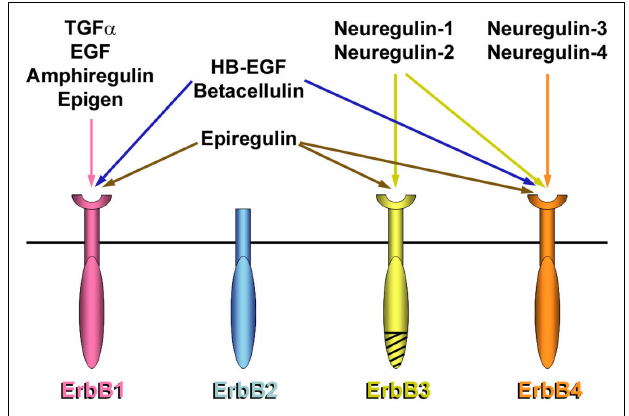
FIGURE 2 |The erbB family of receptors and their ligands. ErbB1 (or EGFR, epidermal growth factor receptor) and erbB4 are fully functional receptors that possess an extracellular ligand-binding domain and a cytoplasmic protein tyrosine kinase domain and can function as homo- or heterodimers. In contrast, erbB2 (or neu), which lacks a ligand-binding domain, and erbB3, which is defective in its intrinsic tyrosine kinase activity (dashed lines), must heterodimerize with another member of the erbB family for signal transduction.The different EGF-like growth factors exhibit different binding specificities for the erbB receptors.WhileTGF α , EGF, amphiregulin, epigen, neuregulin-3, and neuregulin-4 are specific for a single member of the receptor family, the five other EGF-like ligands can bind two or three receptors each. EGF, epidermal growth factor; HB-EGF, heparin binding-EGF;TGF α , transforming growth factor α